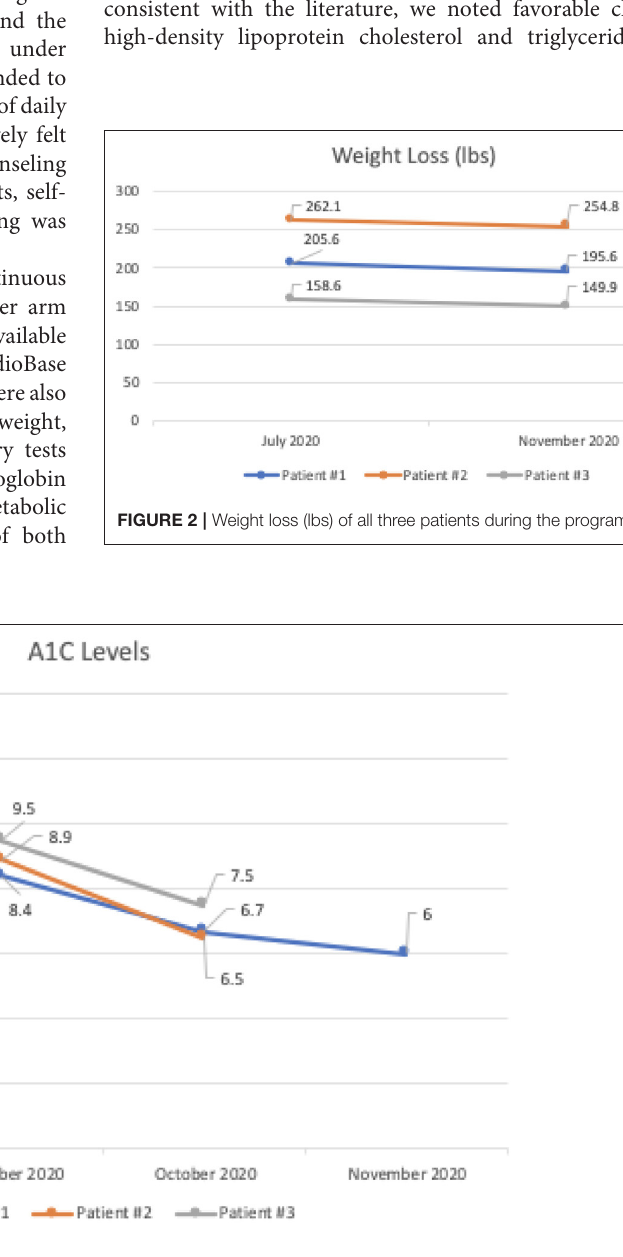
FIGURE 1 | A1C levels of all three patients during the program.